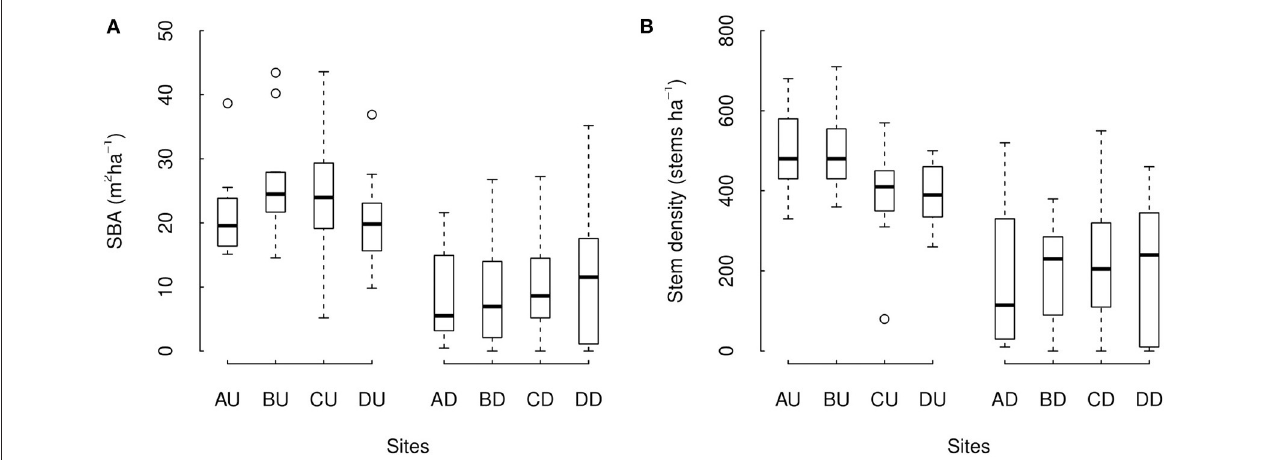
FIGURE 3 | Stand basal area (A) and stem density (B) across sites with different levels of degradation. Sites AU-DU correspond to the undegraded forest sites, and AD–DD to the degraded sites in the areas A–D. Boxes are the interquartile range (IQR), black lines in the middle of boxes are medians, whiskers are the extreme data point with 1.5 ×